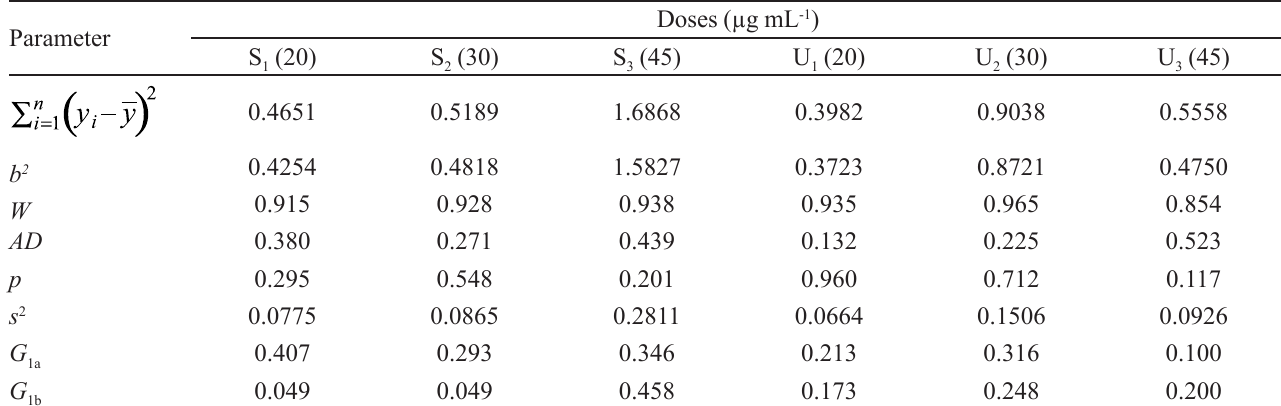
TABLE IV - Statistics obtained for each dose for the ofloxacin microbiological assay, using three-dose level (3x3) Parameter